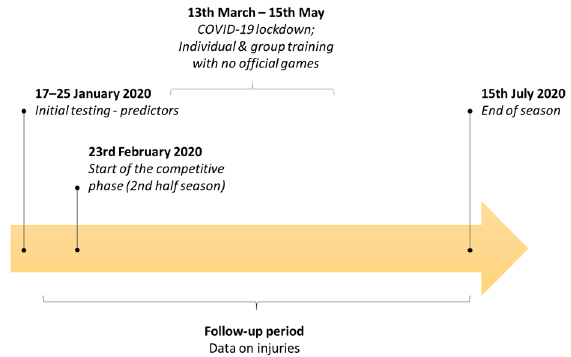
Figure 1. Study Figure 1. Study design.